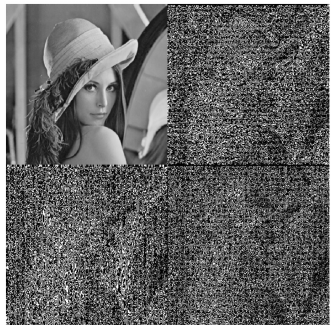
Figure 1. Wavelet transform of the Lena image using one-scale, which are then decomposed into one low-frequency sub-band and three directional